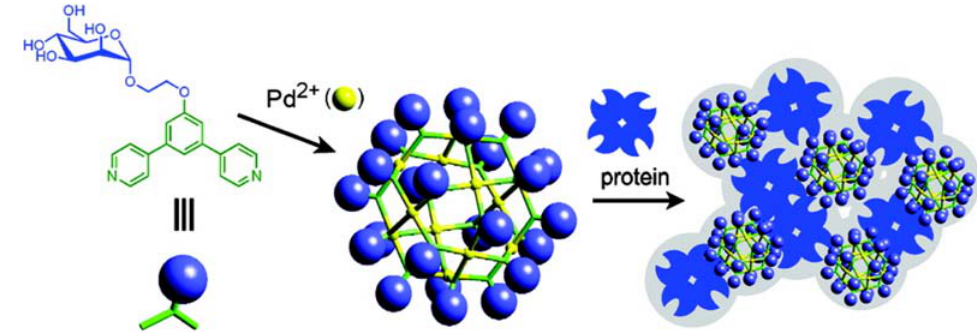
Figure 5. Self-assembly of M 12 L 24 complexes with 24 saccharide moieties at the periphery. When combined with lectins, they form aggregates because of the cluster effect of the saccharides on the spheres. Reprinted with permission from (N. Kamiya; M. Tominaga; S. Sato; M. Fujita. J. Am. Chem. Soc. 2007, 129 , 3816–3817). Copyright (2007) American Chemical